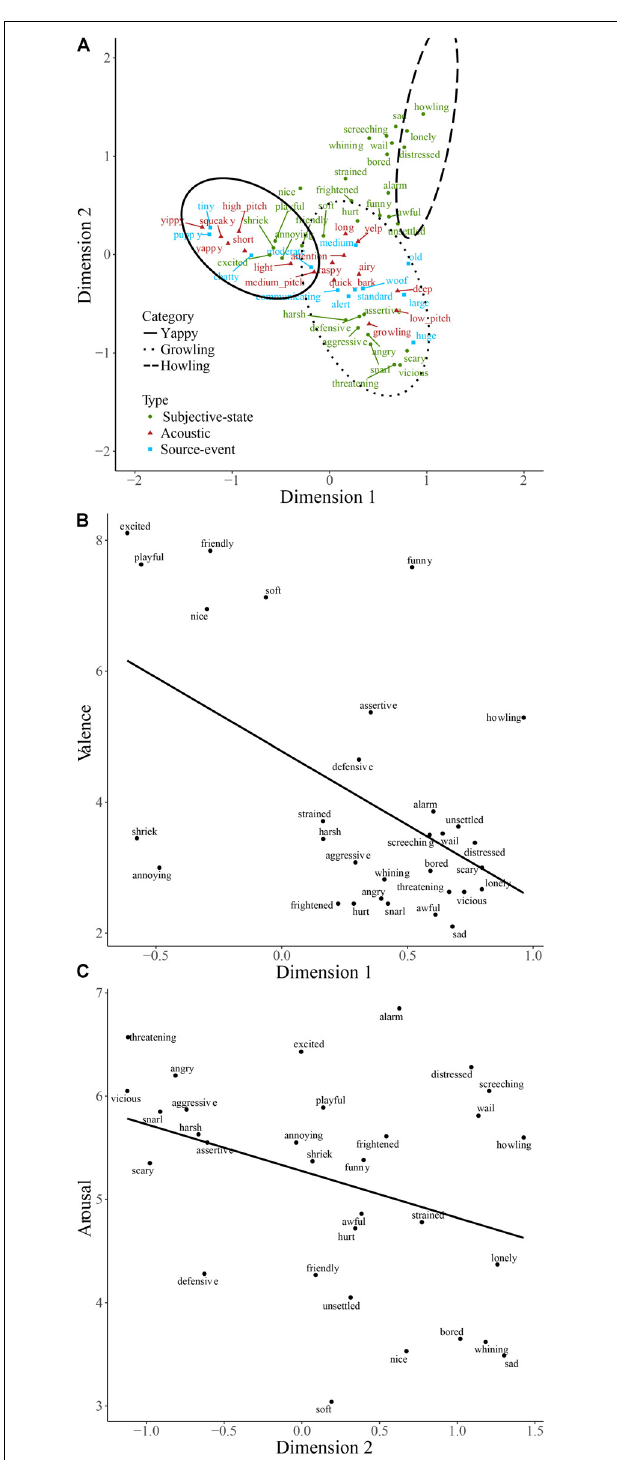
FIGURE 4 | Descriptive words used to describe dog sounds plotted on the first two dimensions of categorization data (A) . Words are colored according to type. The regions of the two-dimensional space corresponding to the three main categories of dog sounds are indicated by solid, dashed, and dotted lines. Valence (B) and arousal scores (C) of affect-judgments are plotted against their coordinates on dimensions 1 and 2,